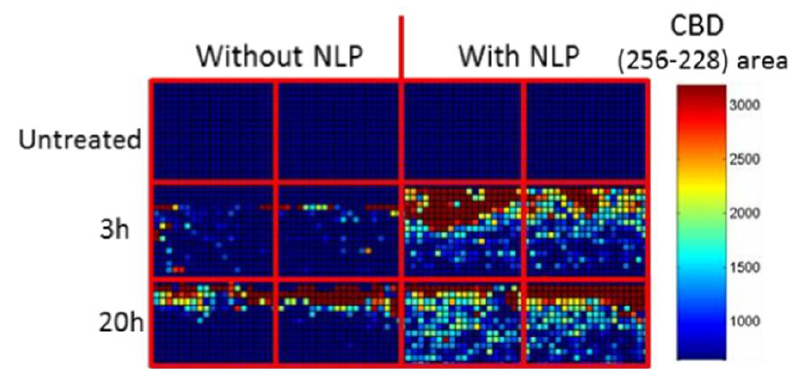
Figure 1. Raman images of the skin cross-section showing the 245 cm − 1 peak area (CBD concentration) for each skin sample at 3-hr and 20-hr.